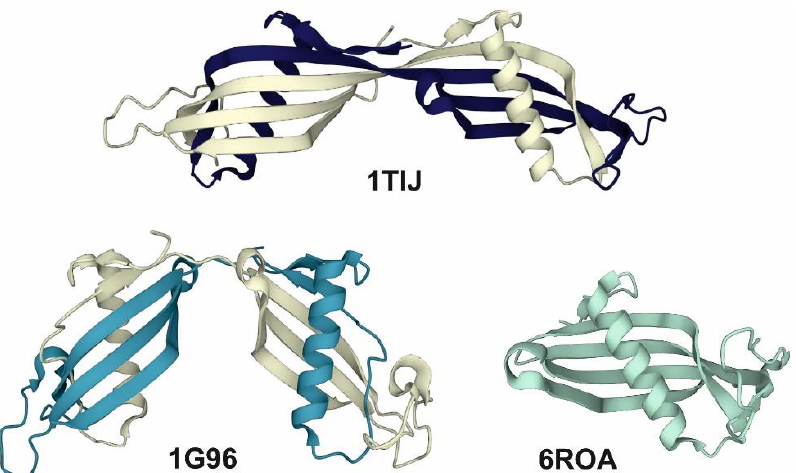
Figure 1. The structure of native HCC dimes in the open (PDB code: 1TIJ [9]) or partially closed (PDB code: 1G96 [5]) conformation and the V57G HCC monomer (PDB code: 6ROA [9]).